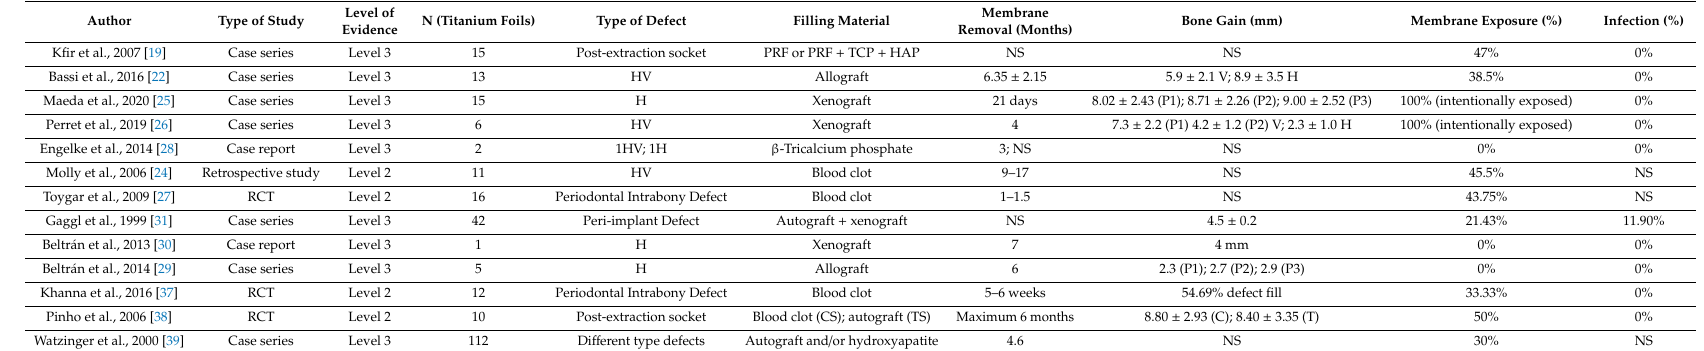
Table 1. Summary of the included studies.